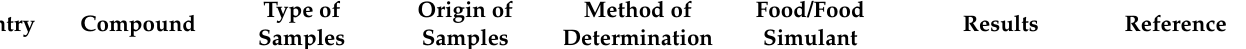
Table 2. Migration levels of PFAS found in foods or food